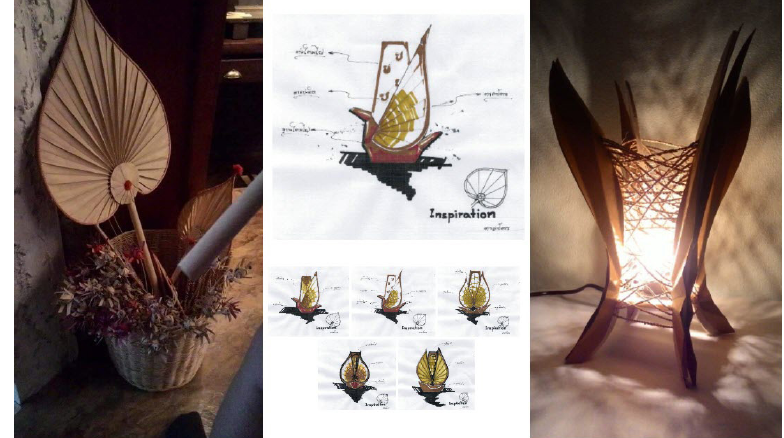
Figure 4. Group 4 design work inspired by talipot fan (source: created by author) Group 5